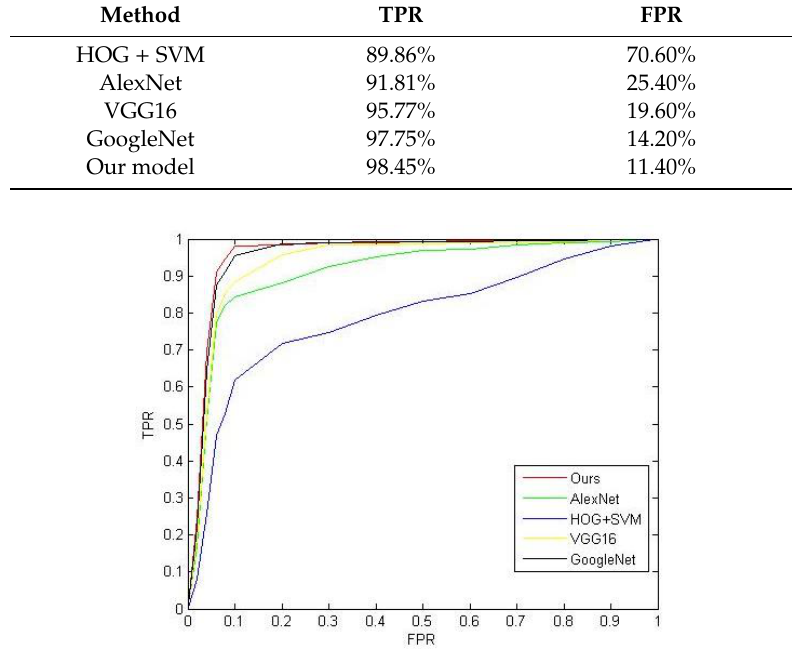
Table 2. Partial training parameters.